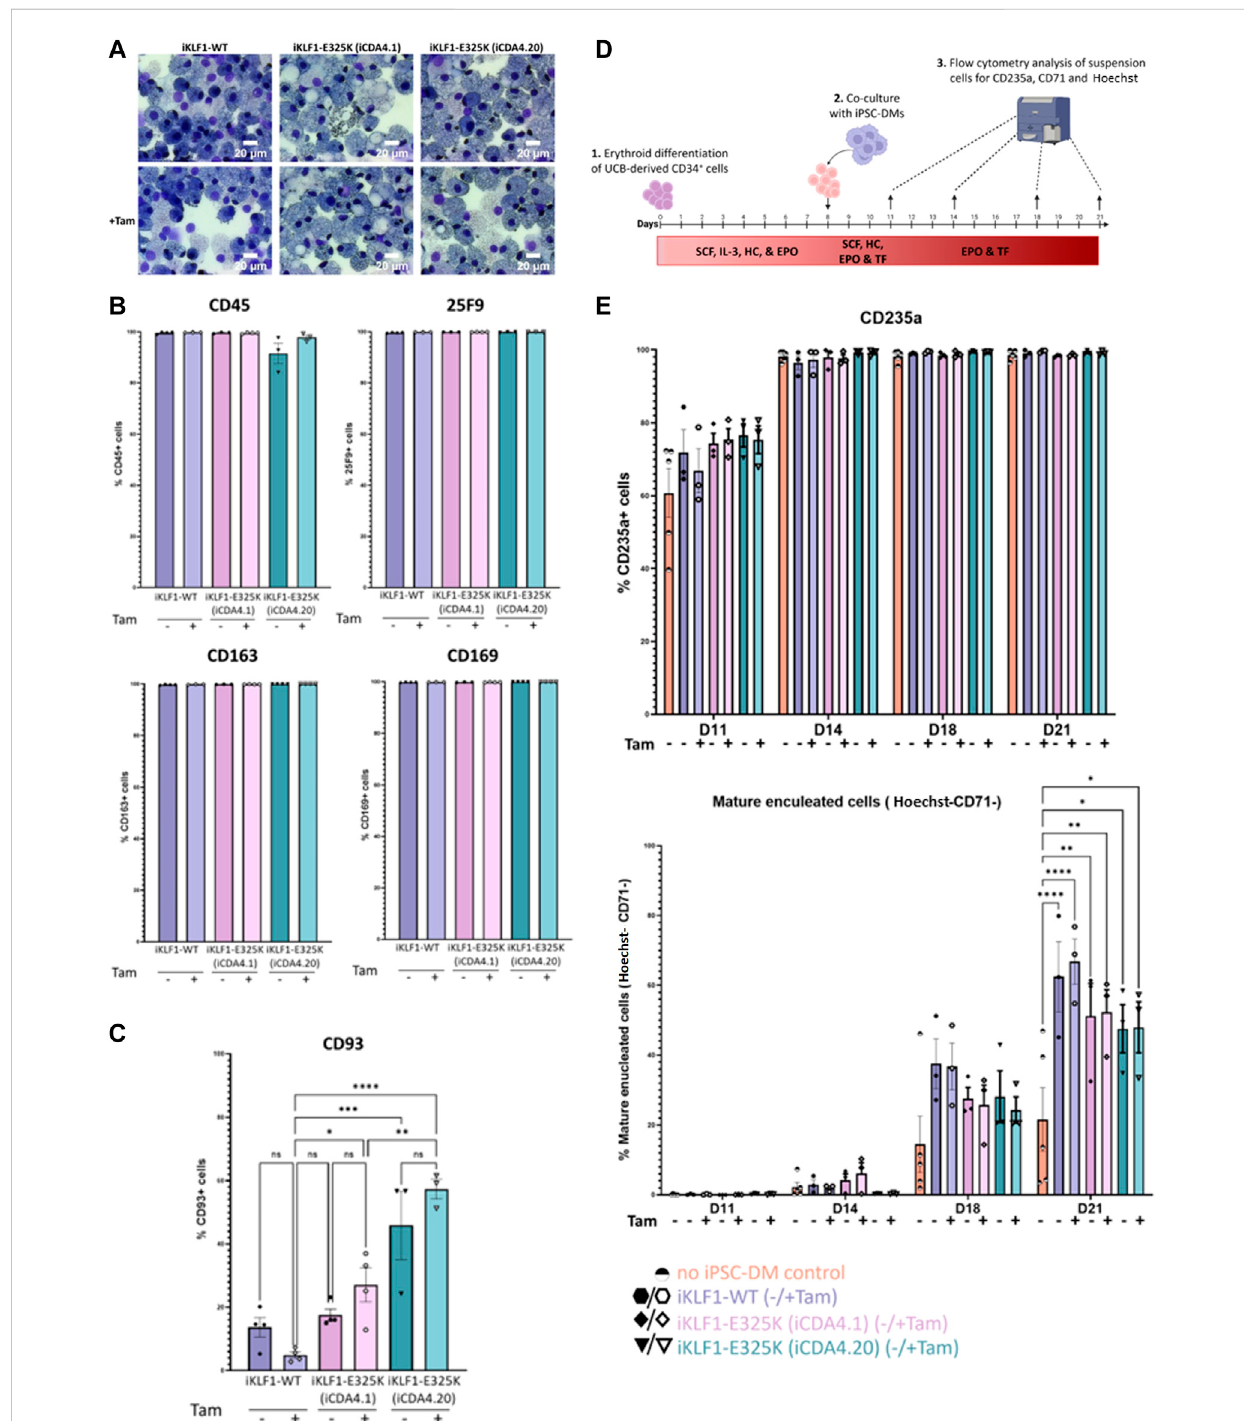
FIGURE 3 Activation of KLF1-E325K slightly impedes phenotypic and functional changes induced by KLF1. (A) Representative KwikDiff stained cytospins of macrophages derived from an iKLF1-WT (iKLF1.2) and two iKLF1-E325K iPSC lines (iCDA4.1 and iCDA4.20). Flow cytometry analyses were performed on macrophages derived from an iKLF1-WT (iKLF1.2) and two iKLF1-E325K iPSC lines (iCDA4.1 and iCDA4.20) (B) Quanti fi cation of fl ow cytometry analyses for cellsurfacemarkerexpressionofCD45,25F9,CD163andCD169.Datapointsrepresentindividualmacrophageharvests.ErrorbarsrepresentSEM.One- way ANOVA with Tukey post-test generated no statistically signi fi cant p -values. (C) Quanti fi cation of fl ow cytometry analyses for cell surface marker expressionofCD93.Datapointsrepresentindividualmacrophageharvests.ErrorbarsrepresentSEM.One-wayANOVAwithTukeypost-test.* p < 0.05,** p < 0.01, *** p < 0.0001. (D) Schematic of in vitro erythroblastic island model protocol. Day 0 – 8: UCB-derived CD34 + cells are cultured with SCF, IL-3, hydrocortisone(HC)andEPO.Day8 – 11:iPSC-DMsareaddedandculturedwiththeerythroidprogenitorswithSCF,HC,EPOandtransferrin(TF).Day11 – 21: Co-cultures are cultured with EPO and TF. At days 11, 14, 18 and 21 suspension cells are analysed by fl ow cytometry for expression of CD235a, CD71 and Hoechst. (E) Quanti fi cationof fl owcytometryanalysesofsuspensioncellsfor CD235a,CD71andHoechst atdays11, 14, 18and 21 oftheculture.Datapoints represent individual experiments. Error bars represent SEM. One-way ANOVA with Tukey post-test. * p < 0.05, ** p < 0.01, *** p < 0.0001.